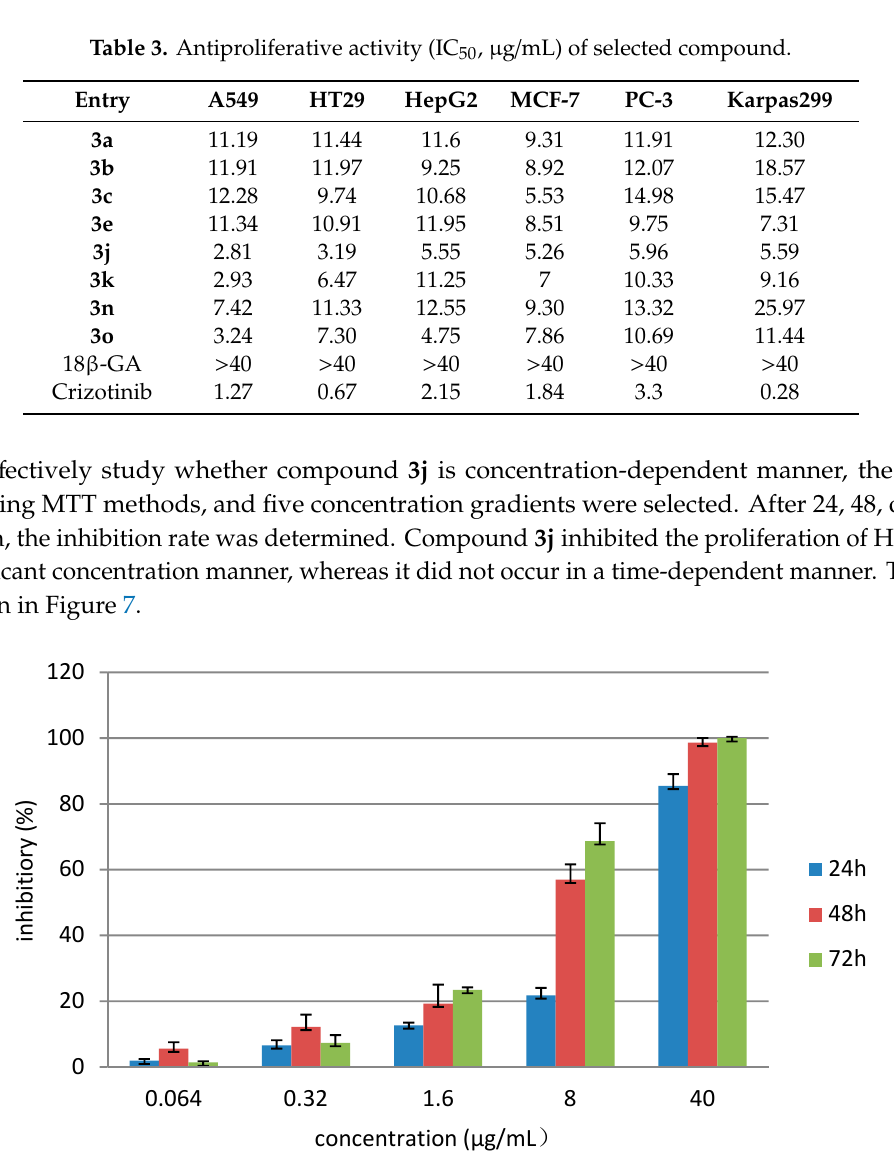
Figure 7. The relationship between different concentrations of compound 3j and cytotoxicity. Data are means ± SD of the inhibition (%) from three independent experiments.